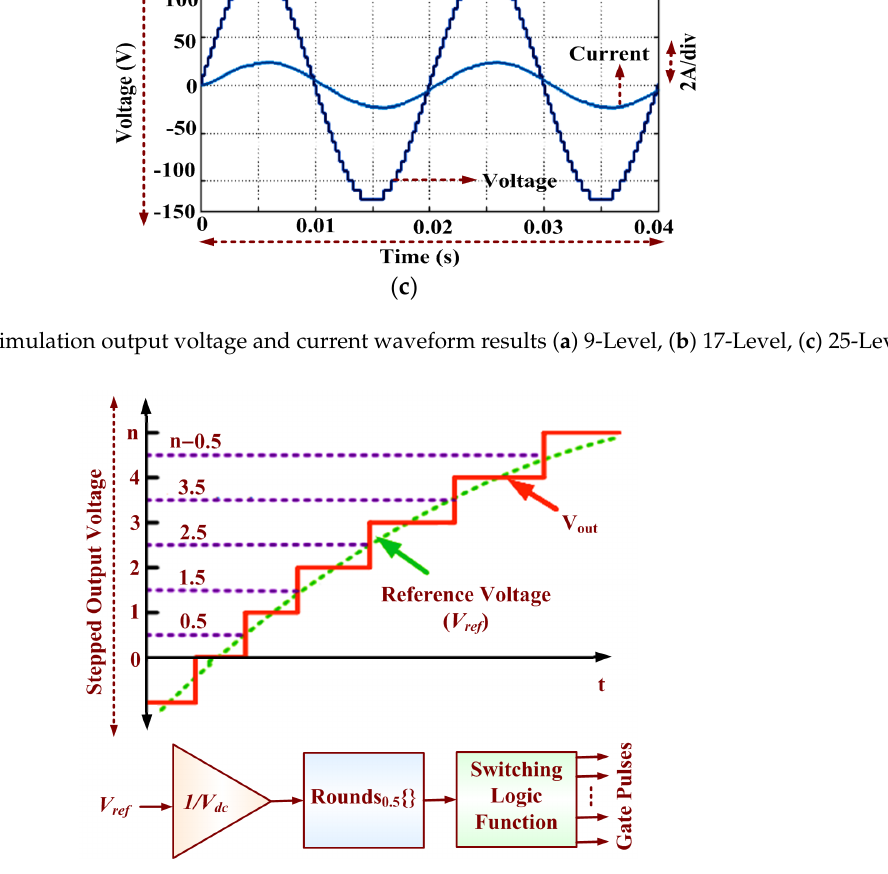
Figure 11. Experimental setup of proposed converter.